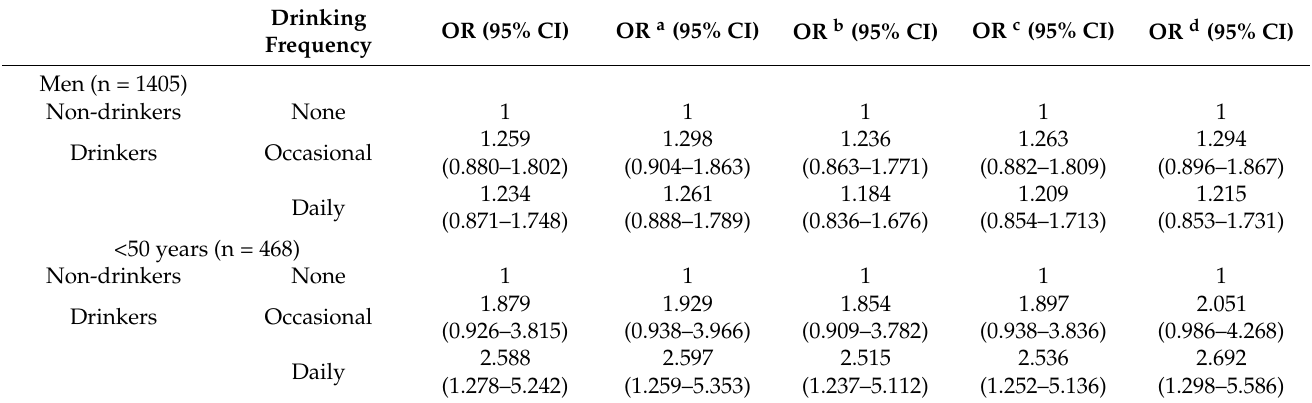
Table 6. Relationship between EE development and drinking frequency according to